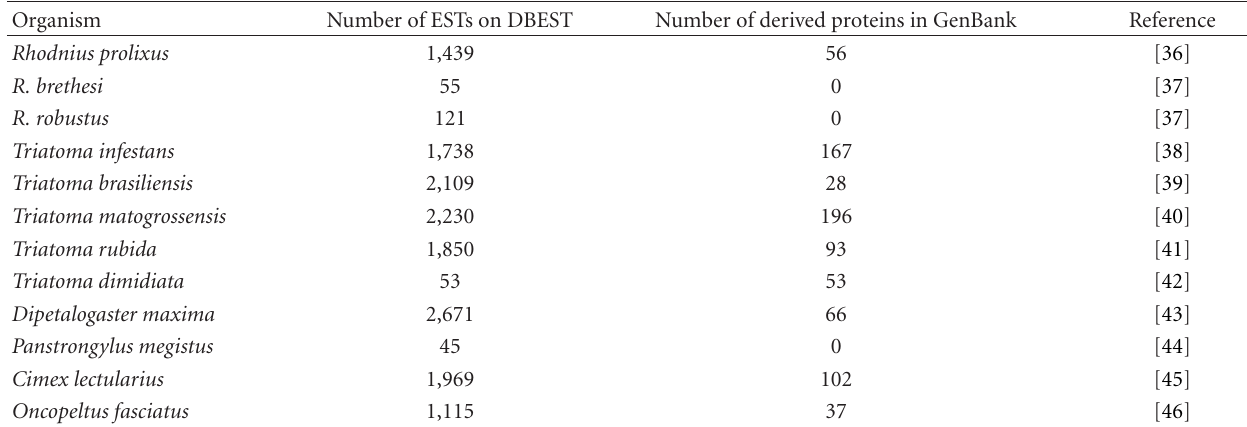
Table 2: Salivary transcriptomes of